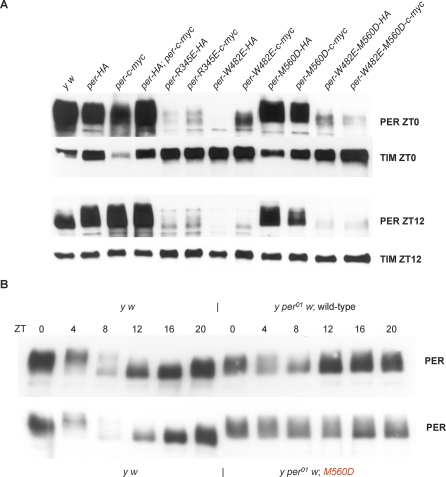
Expression Analysis of Wild-Type and Mutant PER Proteins in Fly HeadsProtein extracts from adult fly heads were prepared as described in Materials and Methods at the Zeitgeber Times (ZT) indicated. As per+ control flies the y w strain was used. In all other lines PER expression occurred from the transgene indicated above the blot in an otherwise per01 genetic background. Blots were incubated with anti-PER (A, B) and anti-TIM antibodies (A). All transgenes were present in homozygous conditions and the following lines were used (A) per-HA 1-5-2; per-c-myc 2-2-2; per-HA;per-c-myc double homozygous made of lines 1-5-2 and 2-2-2; R345E-HA 3–4; R345E-c-myc 4–4; W482E-HA 5–2; W482E-c-myc 6–2; M560D-HA 9-4-2; M560D-c-myc 10-2-2; W482E-M560D-HA 11–6; W482E-M560D-c-myc 12–1.
(B) per-c-myc 2-2-2; M560D-HA 9-4-2. The low PER and TIM signals in the per-c-myc lane at ZT0 are caused by partial degradation of the protein sample.